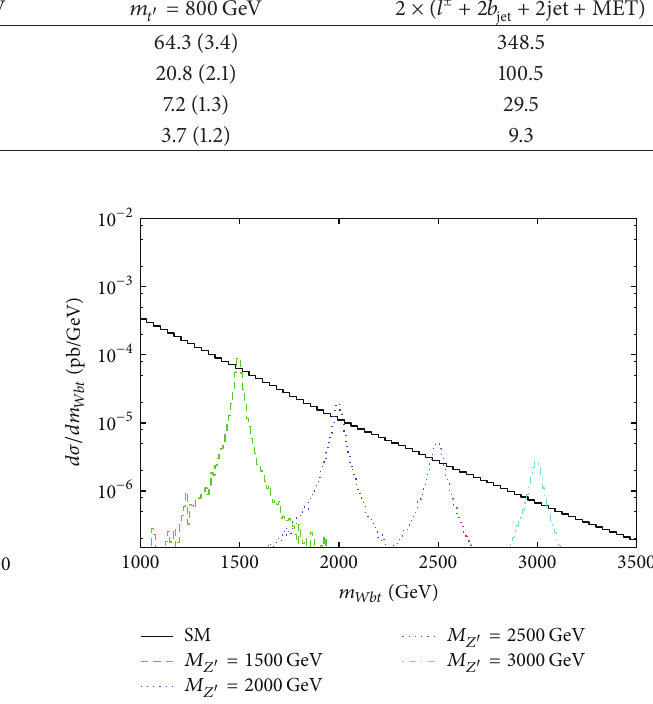
Figure 17: The same as Figure 13, but for 𝑍 󸀠 LP model.